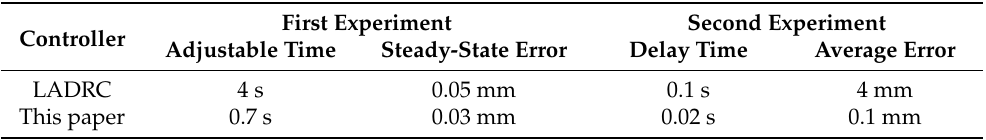
Table 3. Comparison of experimental